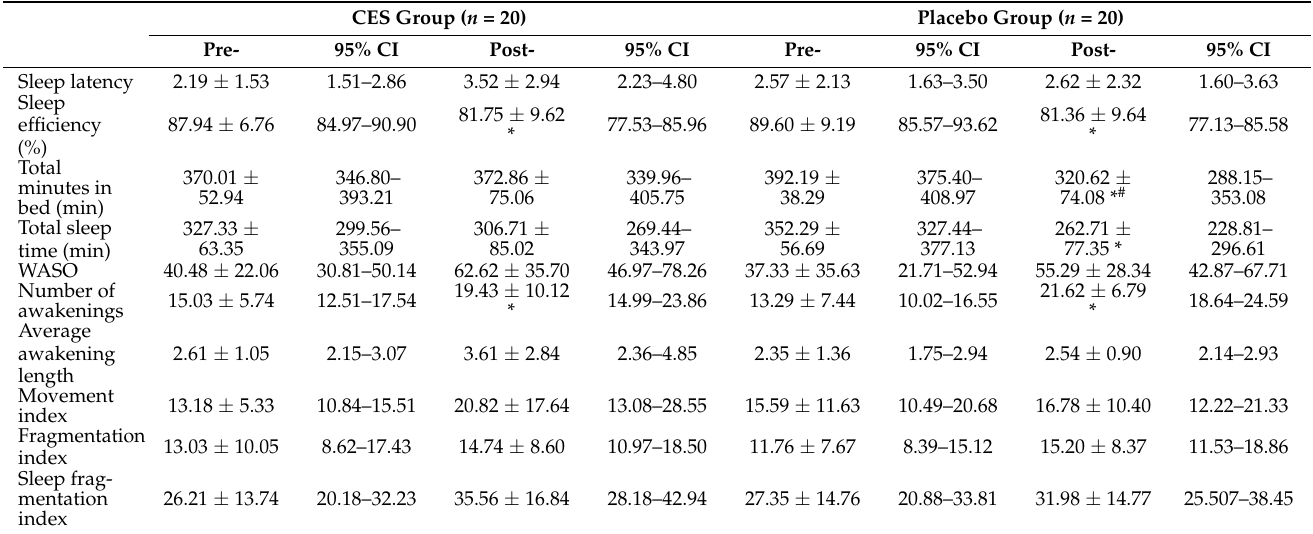
Table 4. Sleep parameters of the two groups as measured through Actigraphy.